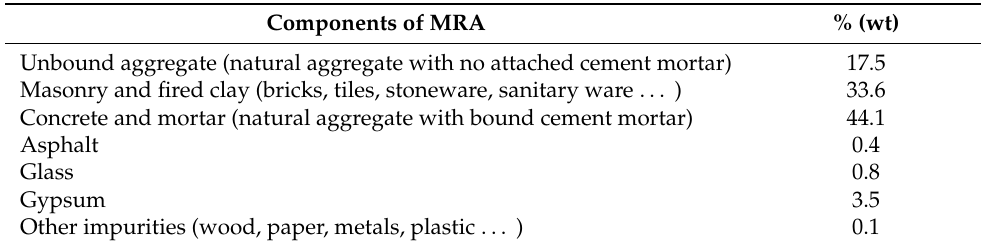
Table 2. Mixed recycled aggregate